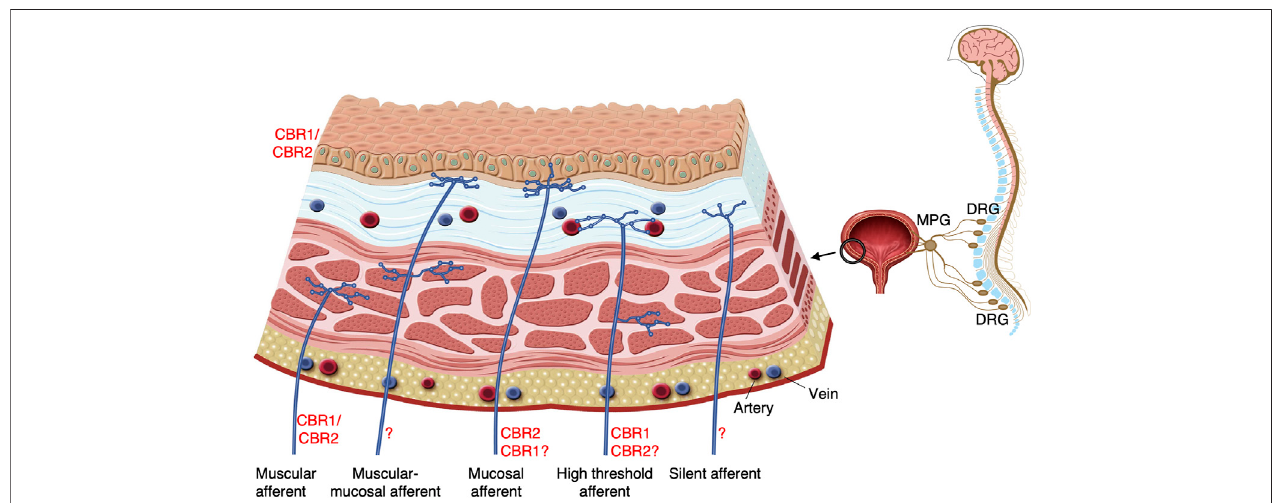
FIGURE 1 | Potential targets of endocannabinoids on bladder sensory nerve endings. At least eight classes of bladder afferents within fi ve major types can be distinguished in the lumbar splanchnic and sacral pelvic neural pathways. These include low-threshold non-encoding and encodings muscular afferents, muscular- mucosal afferents, high- and low-responding mucosal afferents (largely in the lumbosacral DRG innervating evenly all areas of the bladder) and high-threshold muscular and vascular afferents and mechano-insensitive silent afferents (predominantly in the thoracolumbar DRG innervating the base of the bladder) (Xu and Gebhart, 2008; de Groat et al., 2015; Guo et al., 2020). Only fi ve types of bladder afferents illustrated at the fi gure. These classes/types of afferents have receptive fi elds with speci fi c structures and locations within the bladder wall and possess speci fi c combinations of ion channels and receptors which regulate their excitability (Zagorodnyuk et al., 2010; Merrill et al., 2016; Grundy et al., 2019a). Both low- and high-threshold afferents may undergo sensitisation as a result of bladder in fl ammation and thus transmit nociceptive information (Roppolo et al., 2005; Walczak and Cervero, 2011; Yoshimura et al., 2014; Zagorodnyuk et al., 2019). Pelvic low-threshold non- encoding muscular and muscular-mucosal afferents signal mechanical information about micturition and non-painful sensation from the bladder. Low-threshold encoding afferents, high-threshold muscular and vascular afferents, mucosal high-responding and silent afferents probably all detect noxious mechanical and chemical stimuli.Thesethencontributetopathologicalstates, whichresultinlowerurinary tractsymptoms.Potentialtargets ofendocannabinoidsinthebladderincludeCBR1 on the high threshold stretch-sensitive afferents (Walczak and Cervero, 2011); CBR1/CBR2 on the low-threshold distension-sensitive afferents (Aizawa et al., 2014) and CBR2 on the mucosal high-responding afferents (Christie and Zagorodnyuk, 2021). More functional studies are imperative to fully characterise CBR types and their intracellular transduction mechanisms in different classes of bladder afferents.